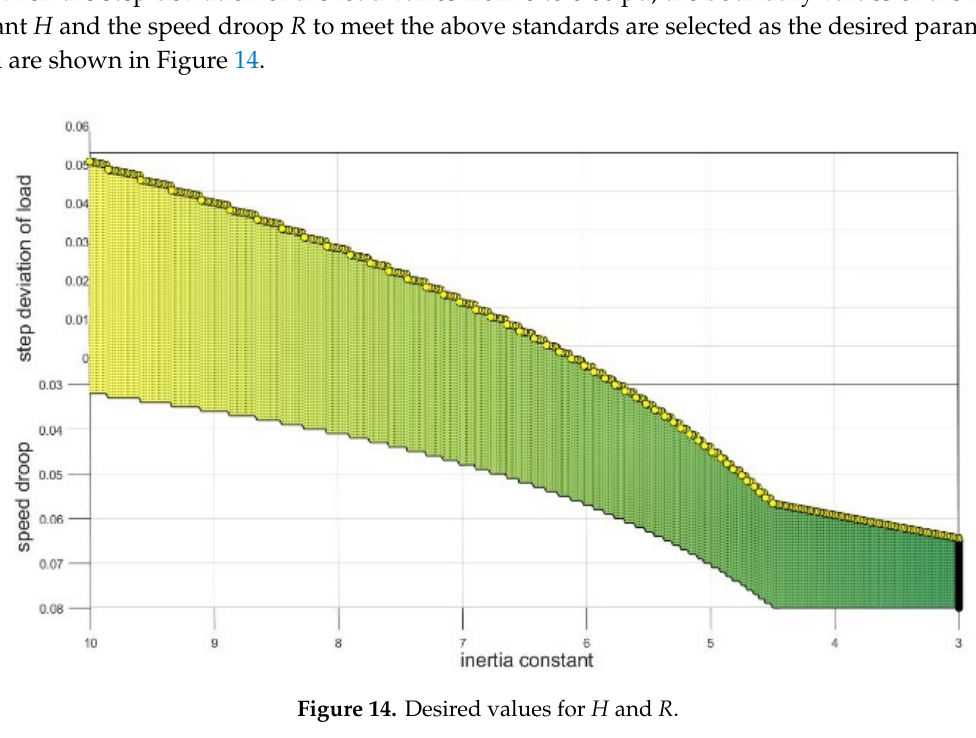
Figure 15. Theological performances of the simplified dynamic system. 5.2. Simulation Results and Analysis When subjected to a step increase of load from 0.01 to 0.06 pu, respectively, the simulation results of the frequency and the ROCOF of the dynamic systems are shown in Figure 16. With the increase of load deviation, the nadir and ROCOF get worse. Clearly, the fixed parameter settings cannot satisfy the standards because they are not adaptive to load changes. 0